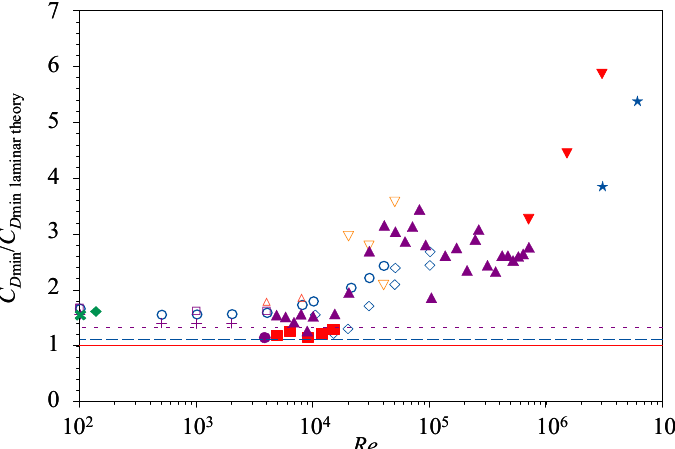
Fig. 6 Normalised C using the laminar-thin-plate-theory value versus C D min versus Re. See Table 1 for symbol’s